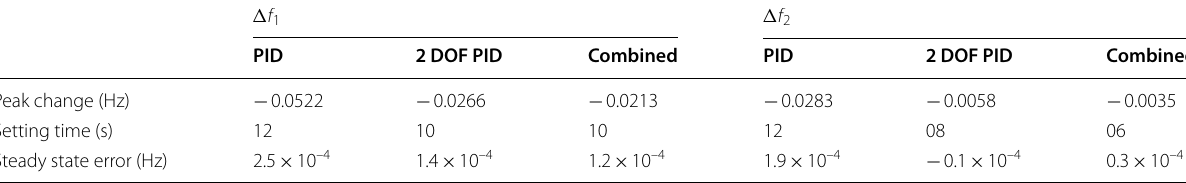
Table 3 Comparison of performance specifications during load perturbation in presence of wind noise